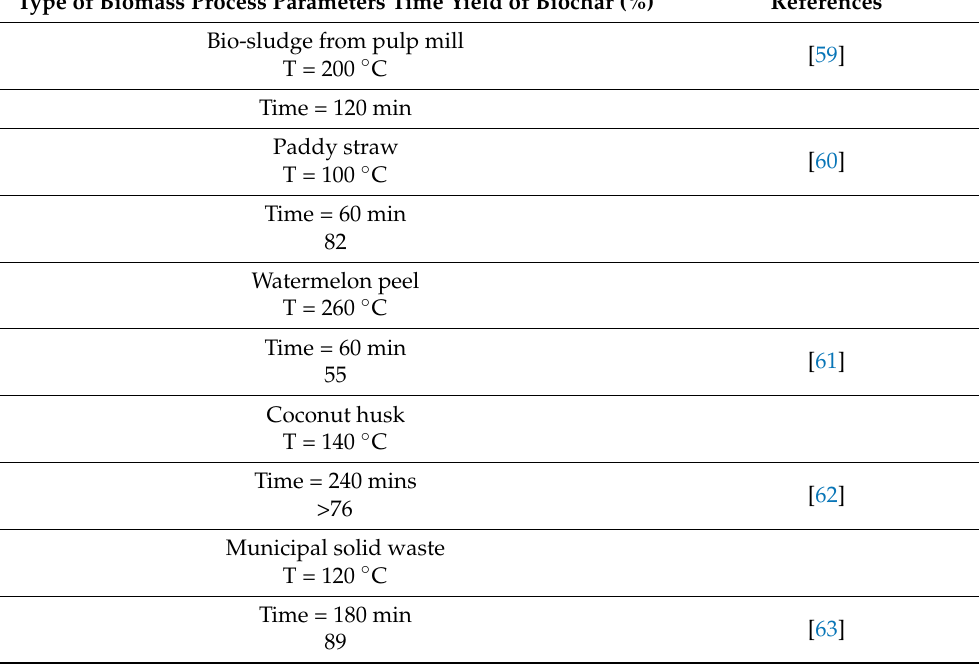
Table 2. Cont. Type of Biomass Process Parameters Time Yield of Biochar